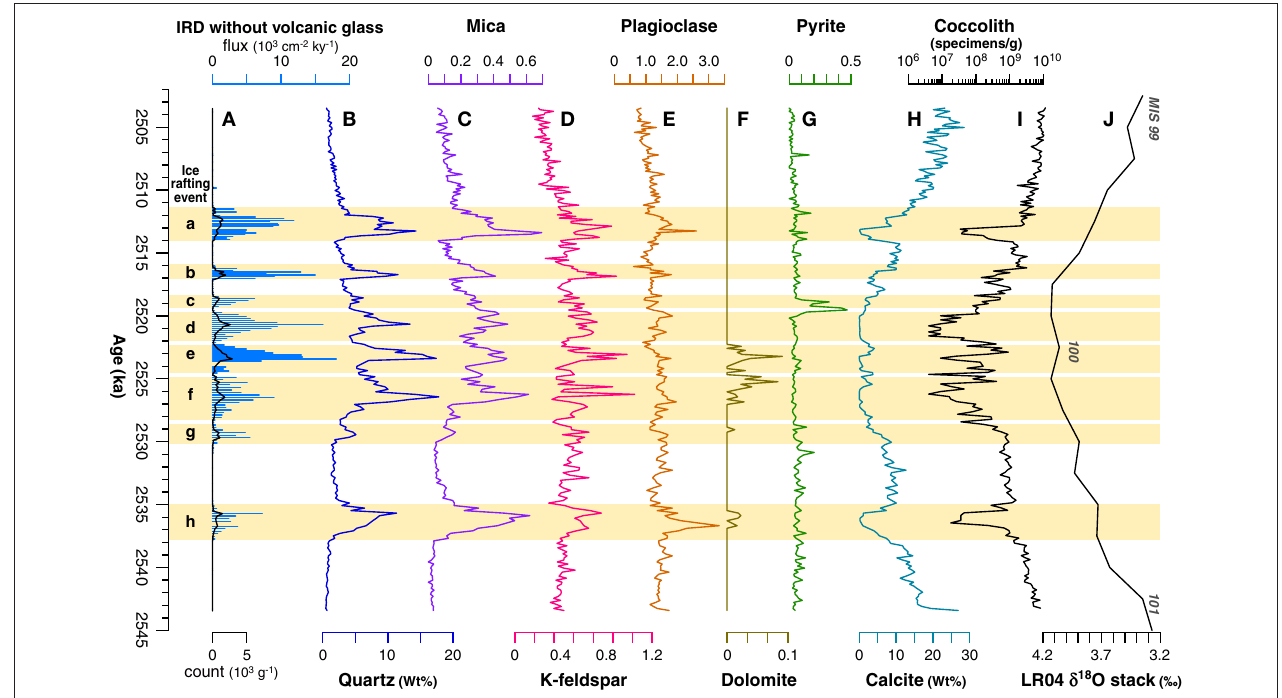
FIGURE 3 | Multi-proxy records of ice-rafting events and ocean surface condition during the MIS 100 glacial period from IODP Site U1314. (A) Ice-rafting events shown by count (black curve) and flux (blue bars) of IRD without volcanic glass; (B–H) Mineralogical characteristics of IRD (XRD measurements); (I) Ocean surface condition shown by count of coccoliths (logarithmic plot); (J) Global ice volume shown by the LR04 stack (Lisiecki and Raymo, 2005). In (B) and (H) , amounts of quartz and calcite were plotted in weight percent. Amounts of the other minerals were not large enough for estimating weight percent, and were represented by the values of the following representative diffraction peaks relative to that of ZnO (2.81Å): K-feldspar (3.24Å and 3.25Å), mica (10Å), plagioclase (3.21Å and 3.19Å), pyrite (2.71Å), and dolomite (2.89Å).